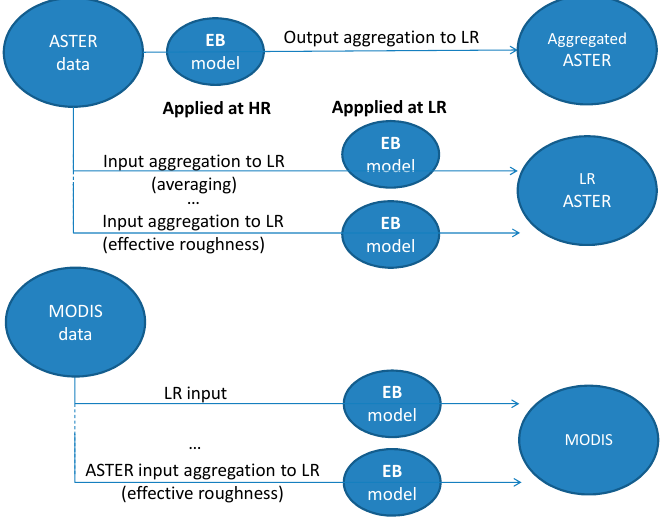
Figure 3. Model application rationale (energy balance model is either SEBS or TSEB).